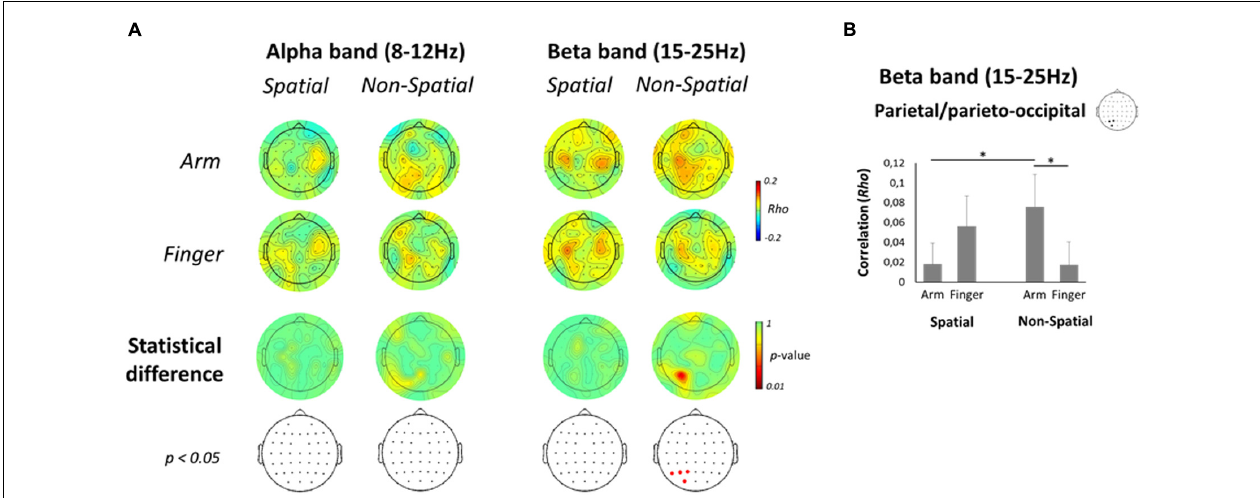
FIGURE 8 | Correlation between EEG activity and RT. ( A , top two rows) Scalp topographic maps of correlation coefficients between alpha- (left) and beta-band (right) single-trial ERD values in the Late planning epoch and RTs, presented separately for each Effector and Precue condition. ( A , bottom two rows) Scalp topographic maps of the statistical difference in correlation coefficients between the Arm and Finger conditions, along with the electrodes that survive a p < 0.05 criterion. (B) Mean correlation coefficient between beta-band ERD and RT for each Effector and Precue condition in the left parietal/parieto-occipital ROI. Asterisks denote a significant difference at p <